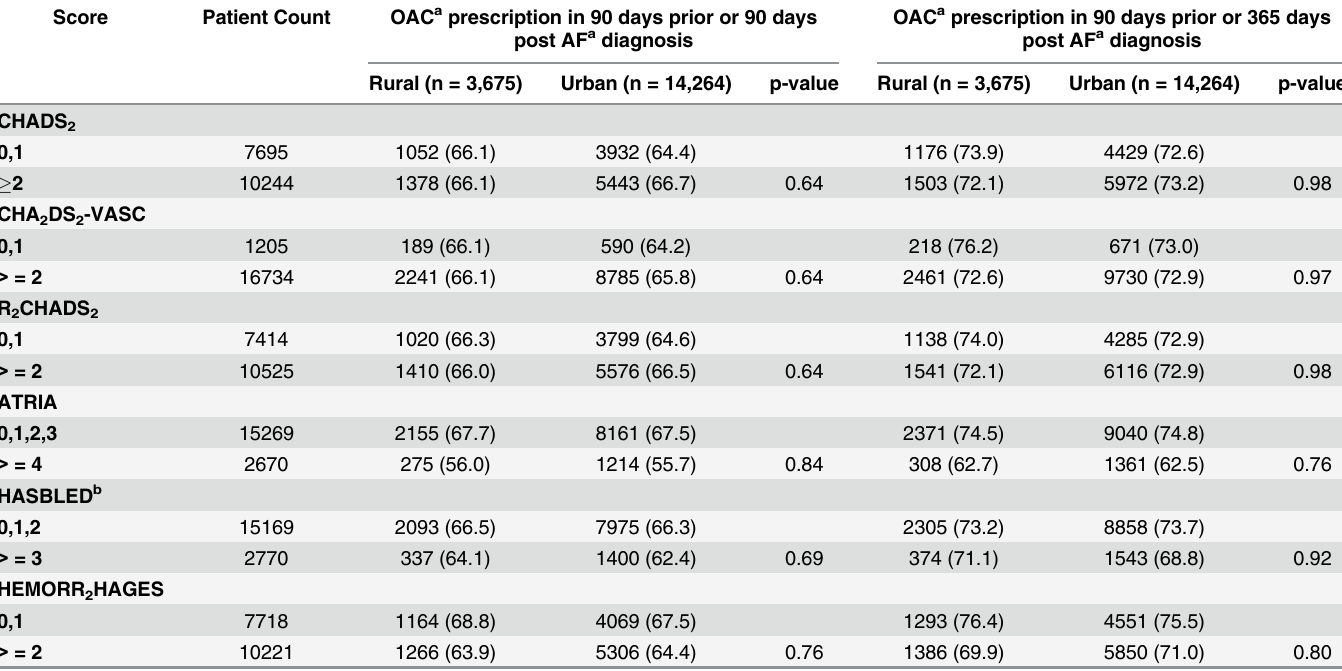
Table 2 legend a AF represents atrial fi brillation; OAC represents Oral Anticoagulant. b HASBLED does not take into account aspirin intake Numbers are n (%) except for patient count and p-value. P-values are from Cochran-Mantel-Haenszel test for association between urban/rural and OAC prescription, controlling for risk scores (two levels